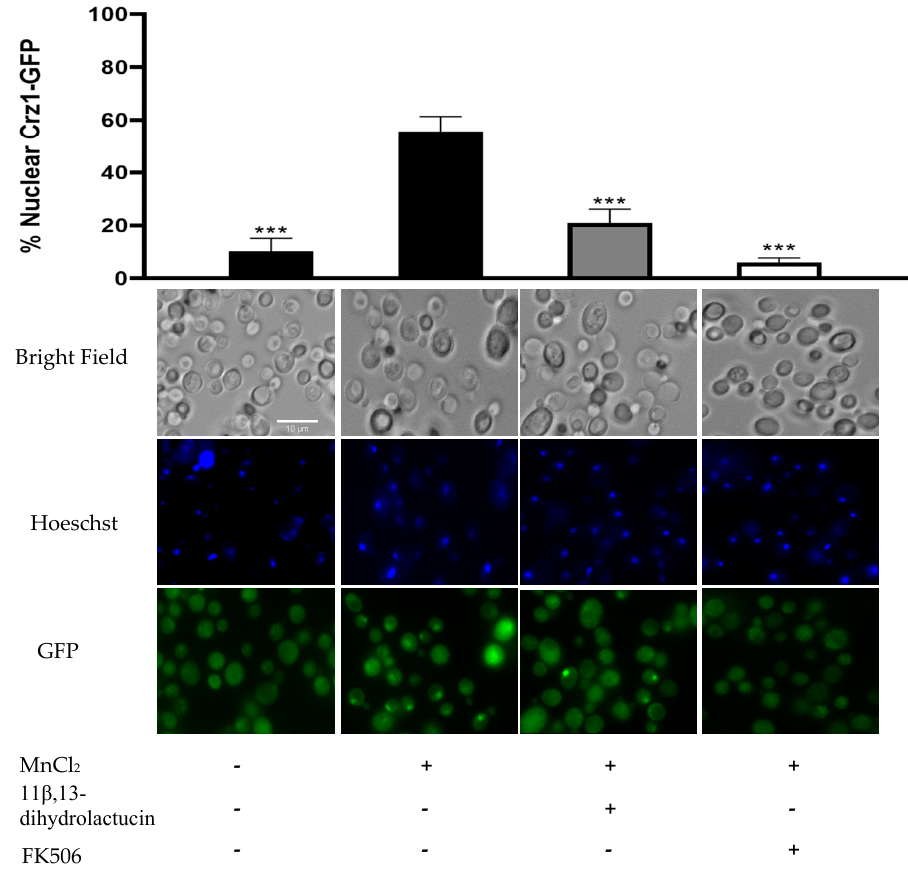
Figure 6. 11 β ,13-dihydrolactucin inhibits Crz1-GFP nuclear accumulation. YAA3 cells were first treated or not with 3.6 µ M of 11 β ,13-dihydrolactucin, challenged with 3 mM MnCl 2 and Crz1-GFP subcellular distribution was monitored using fluorescence microscopy. The immunosuppressant FK506 was used as a positive control. Approximately 1800 cells for each condition were counted. Representative imagens are shown, and the values represent the mean of percentage of nuclear Crz1-GFP ± SD of three biological replicates. Statistical di ff erences are denoted as *** p < 0.001 relative to activated